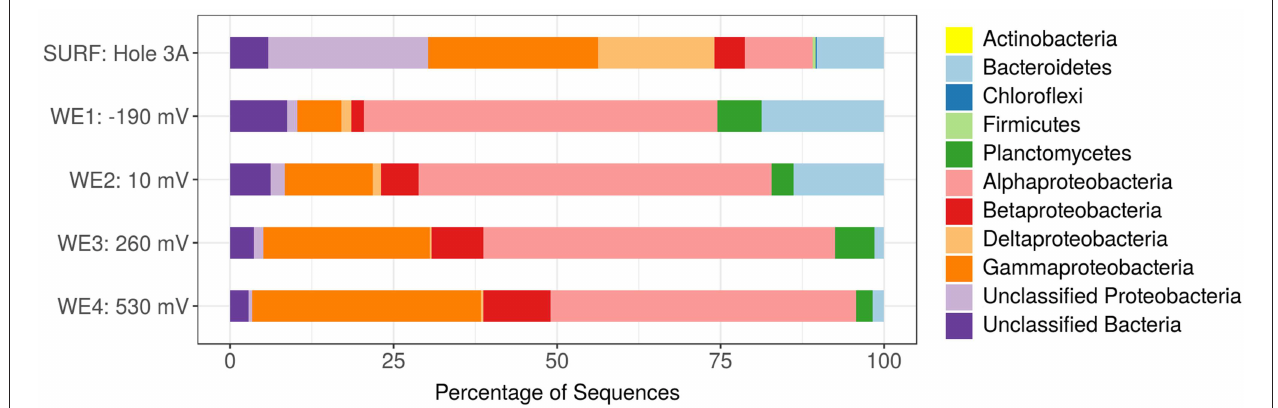
FIGURE 2 | Phylum classification of the active in situ bacterial community of DUSEL 3A fluid (labeled SURF: Hole 3A) and the four separate working electrodes in the in situ electrochemical colonization (ISEC) reactor (labeled WE1-WE4). The unclassified (e.g., putatively novel microbiota) were relatively more abundant at the reducing potential ( − 0.19V vs. SHE) where bacteria use the electrode as the electron donor.